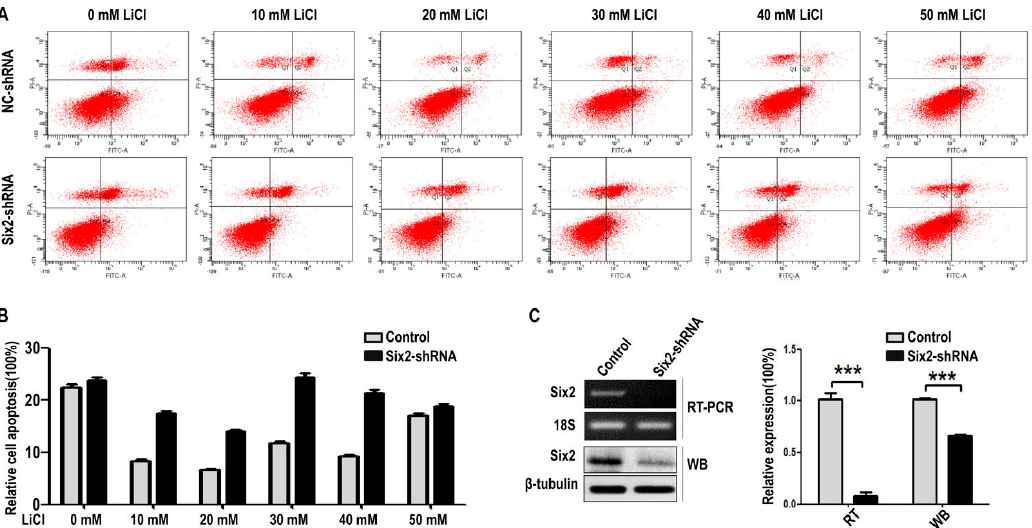
Figure 5. Knockdown of Six2 gene accelerates cell apoptosis while LiCl treatment of low-concentration inhibits cell apoptosis in mK3 cells. ( A ) mK3 cells were transfected with negative shRNA control and Six2 -shRNA for 36 h and treated with LiCl of increasing dosages. The apoptosis was detected by FCM; ( B ) Statistical analysis of cell apoptosis and histogram was drawn in GraphPad Prism 5; ( C ) The efficiency of knockdown Six2 at mRNA and protein level, compared with internal control 18S and β -tubulin, respectively. Values were presented as mean ± SEM ( n = 3), *** p < 0.001 relative to control.